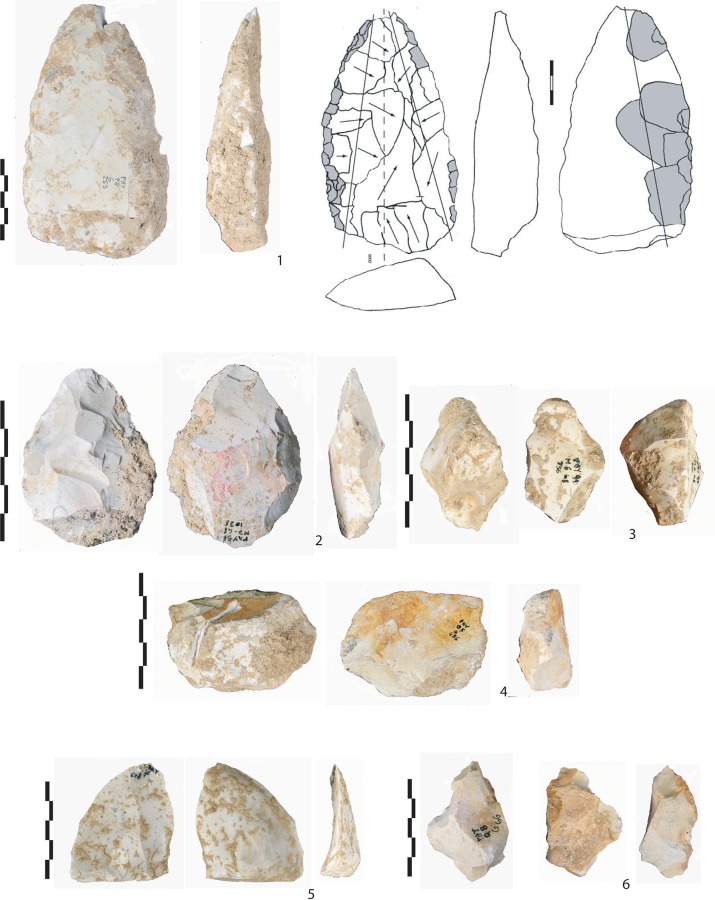
Overview of flint artefacts found in level Gb.(1) A biface tool on a large flake (F33, <30km), (2) biface tool on a small flake (F14, local), (3) abrupt retouch (“museau-type”) on a thick flake (F14, local), (4) a transversal scraper (F14, local), (5) unretouched flake (F34, semi-local), and (6) Bec-borers (F14, local).